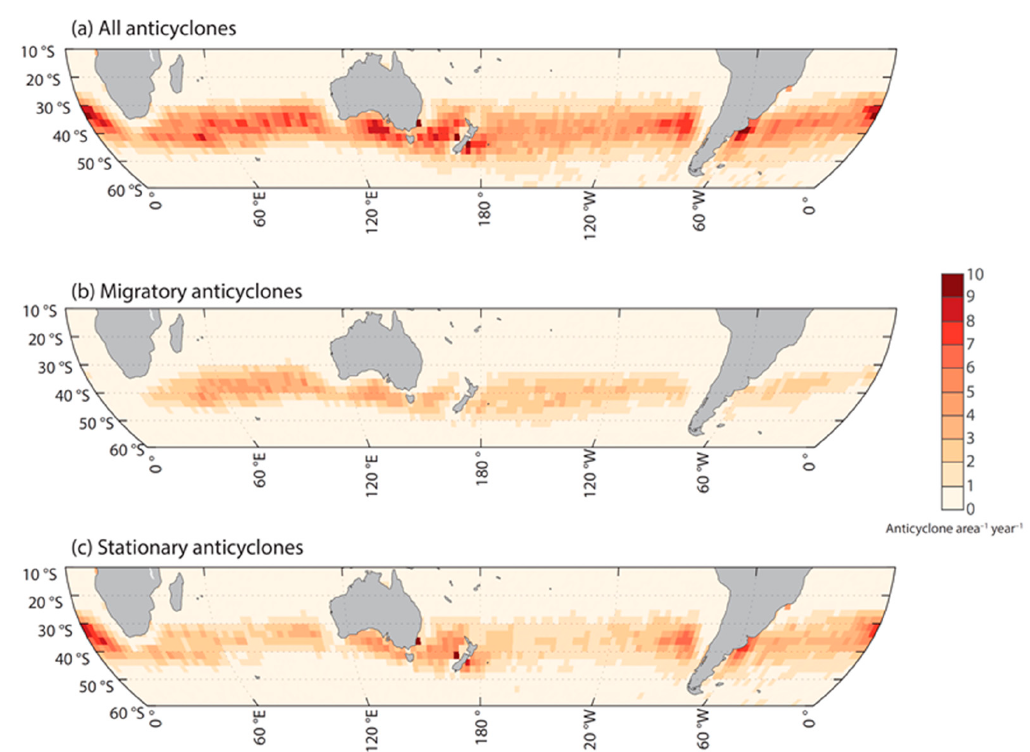
Figure 9. Annual density of anticyclones in the southern hemisphere (anticyclone per area per year). ( a ) All anticyclones, ( b ) migratory anticyclones and ( c ) stationary anticyclones.